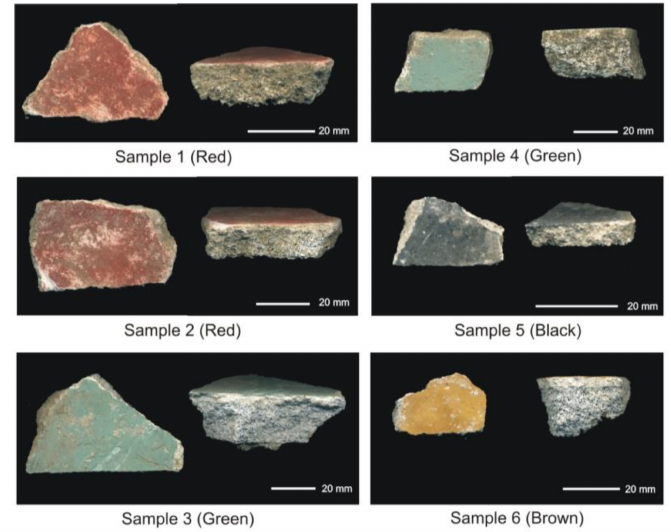
Figure 1. Macroscopic photos of the wall painting fragments analyzed in this